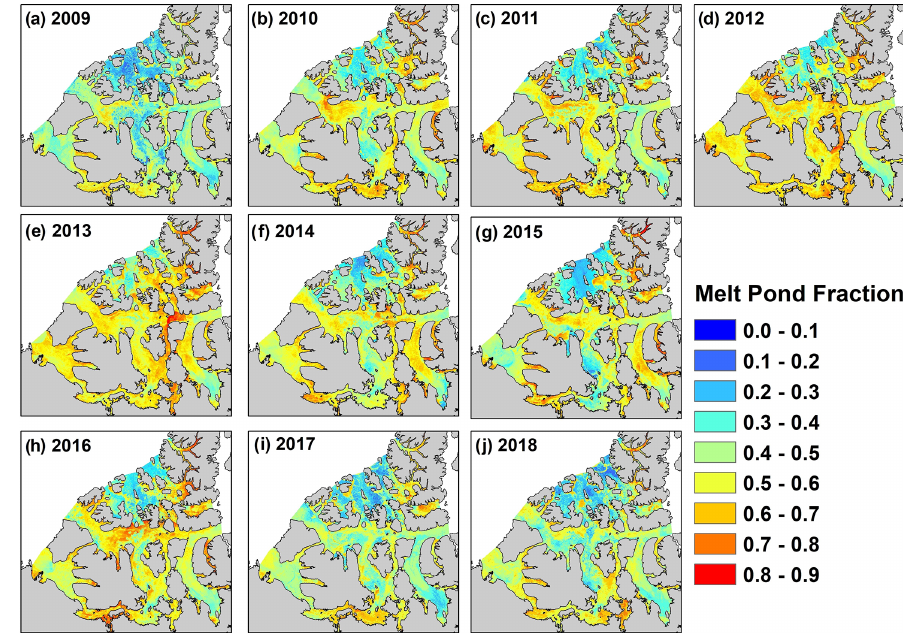
Figure 3. Spatial distribution of RADARSAT-2 peak melt pond fraction ( f pk ) in the Canadian Arctic Archipelago from 2009–2018 (a–j) .